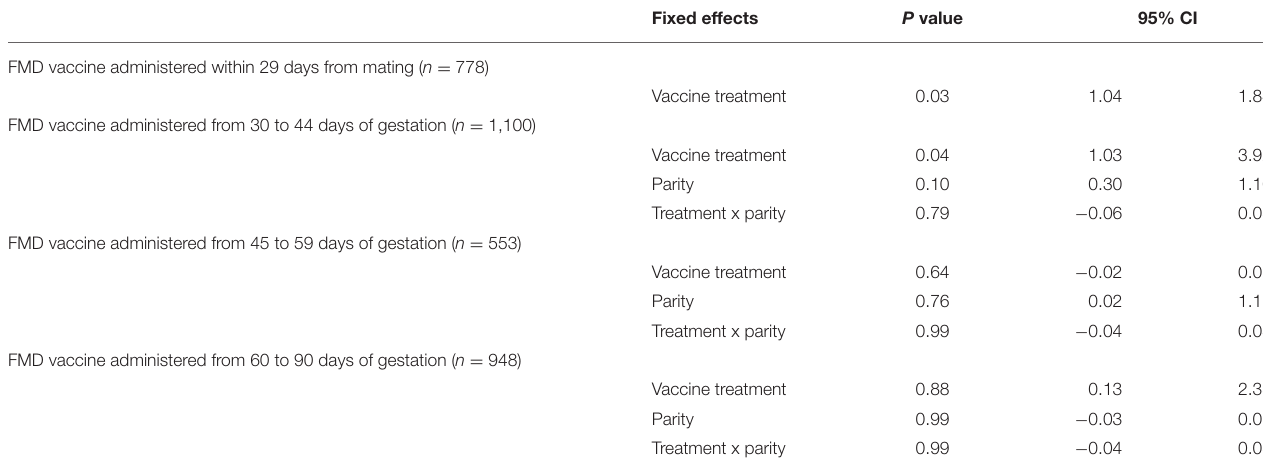
TABLE 1 | Statistical results of pregnancy failure in beef cows receiving or not receiving vaccination against foot-and-mouth disease (FMD) at different gestational ages. Fixed